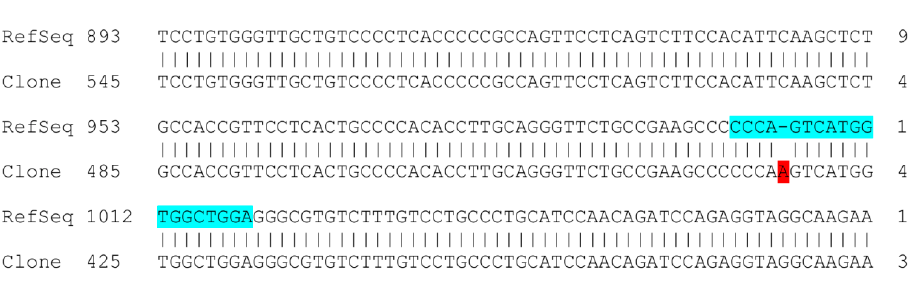
Figure 3. Sequence analysis of the genomic DNA of FLOT1 knockout clone 2. A genomic region of 570 bp comprising exon 3 and the flanking intronic regions was PCR amplified, cloned into a vector, and six clones were sequenced. The numbering of the reference sequence (upper row) corresponds to the human FLOT1 reference gene sequence (NC_000006.12, region 30.727.709-30.742.851, complementary strand). The gRNA sequence is highlighted in light blue, the insertion of an A with red.